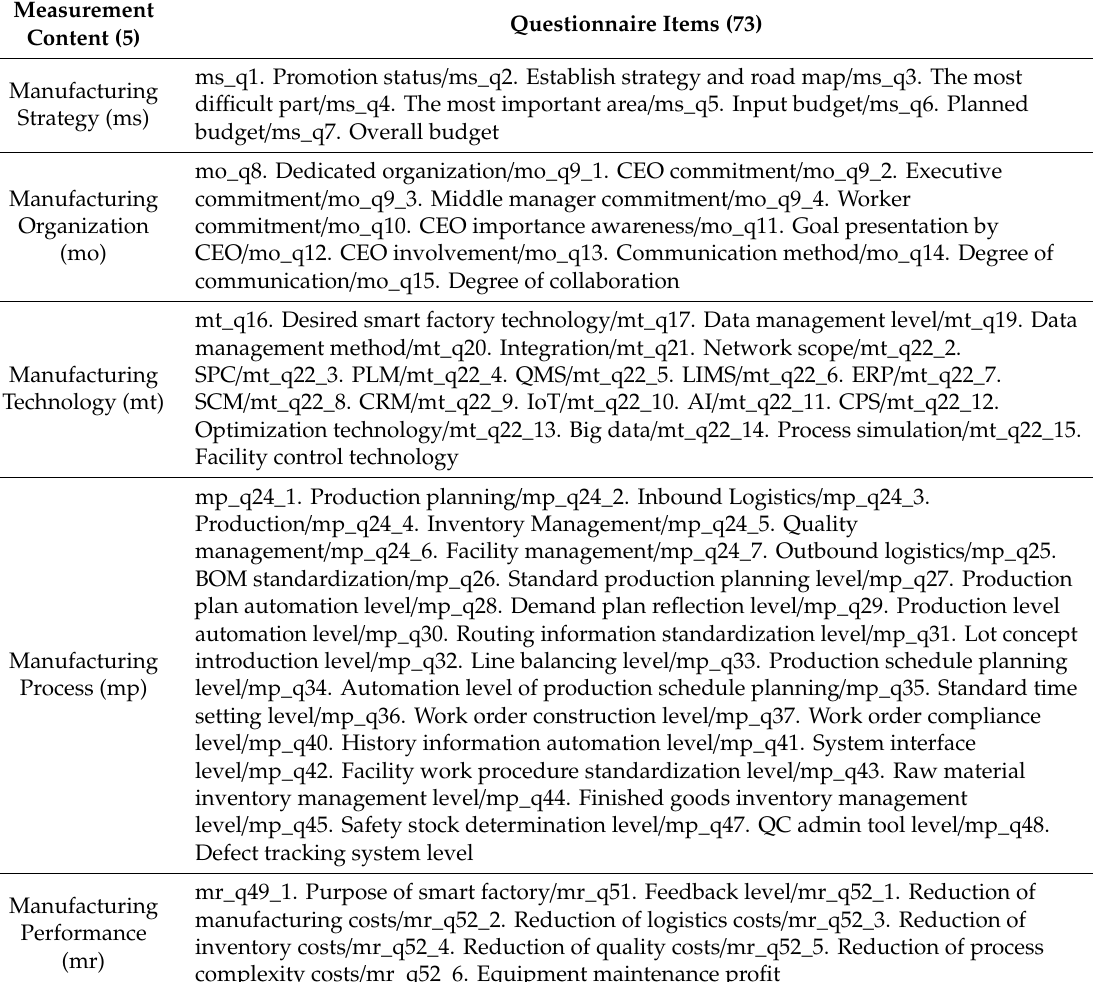
Table 2. Questionnaire